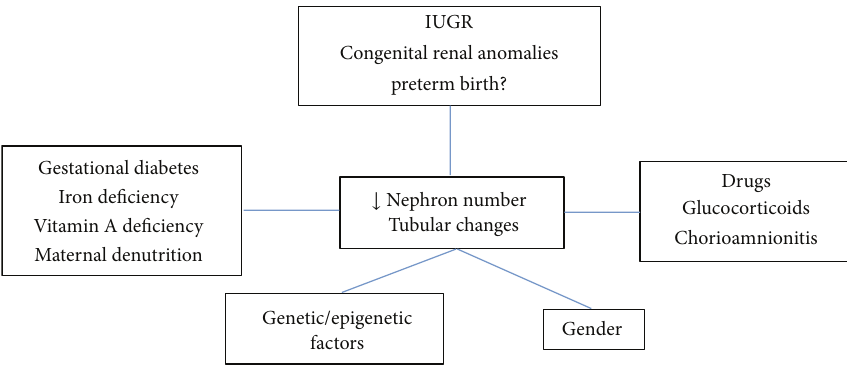
Figure 1: Factors influencing nephron